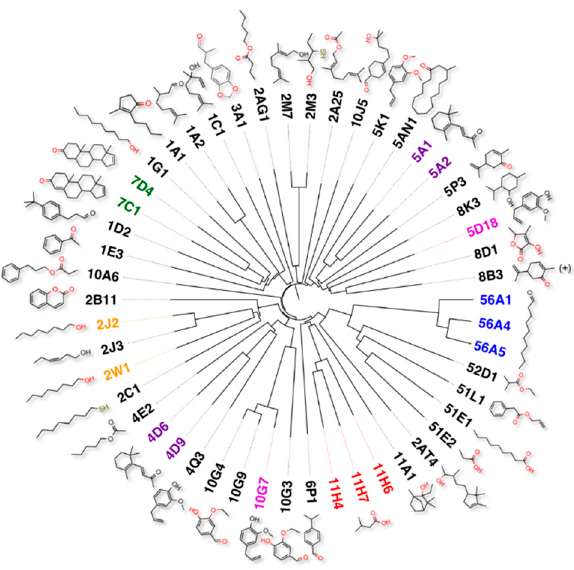
Figure 2. Phylogenetic tree of the 50 human receptors so far deorphanised. Each receptor is associated with the structure of its best ligand. In several cases, two or more receptors are tuned to the same odour (indicated with same colour). Such redundancy likely insures that important odours can be detected in case some receptors become faulty of silenced. On the other hand, this observation allows us to predict that the total number of basic odours representing the olfactory code (and therefore the number of sensors required for an artificial nose) can be significantly lower than the 300–350 functional genes encoding for olfactory receptors in the human genome.